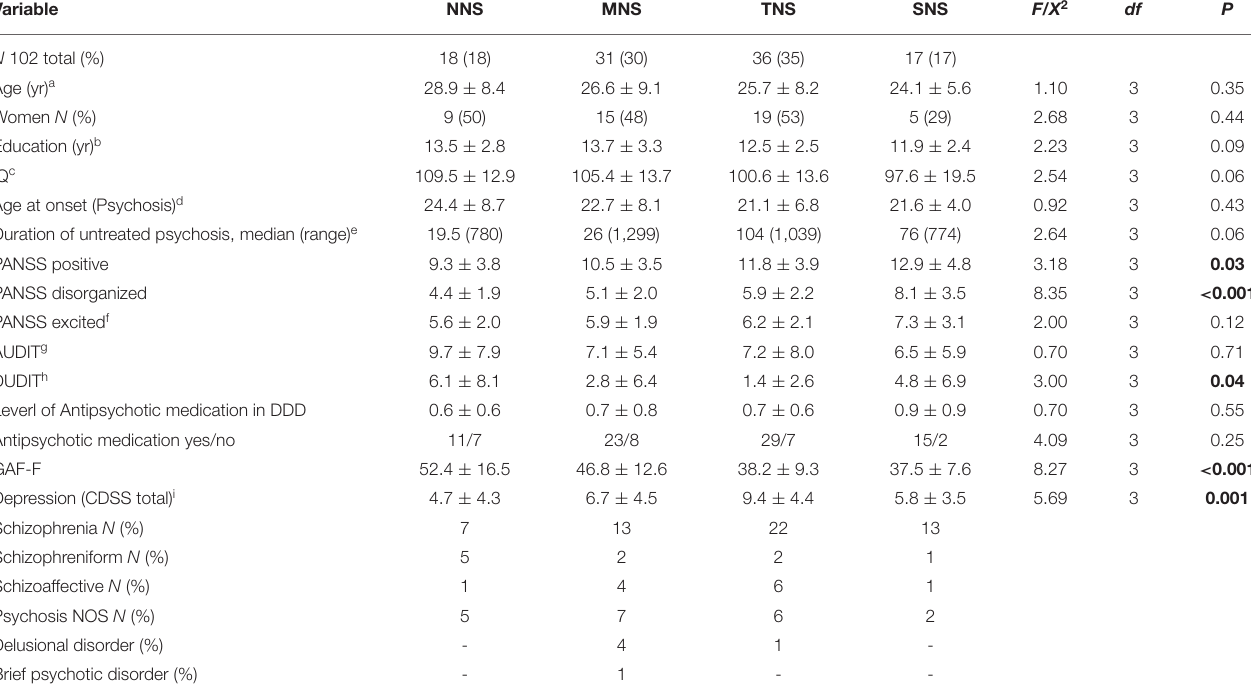
TABLE 1 | Baseline descriptive information for the different patient groups. Variable